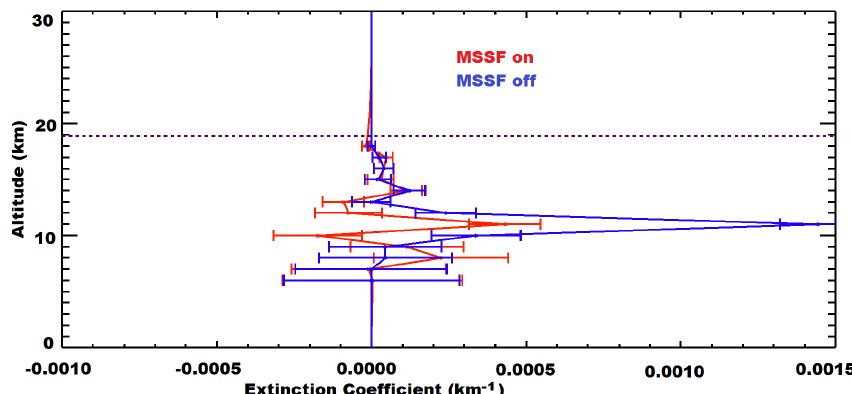
Fig. 18. Extinction coefficient retrieved from MARSCHALS scan 51 with the standard analysis (MSSF module off, in blue) and with MSSF module on (in red). The horizontal dashed line indicates the aircraft altitude during scan acquisition.